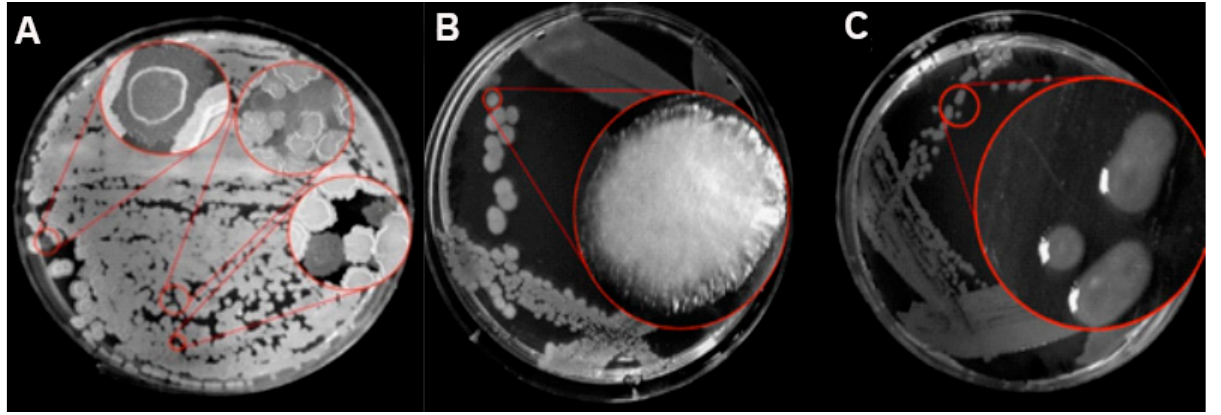
Figure 1. The occurrence of phase variation in B. mojavensis PS17 ( A ). B. mojavensis PS17 morphotype I ( B ) and morphotype II ( C ) grown on 2×SG agar medium plate. Red circles show magnified colonies from specific sites on plates.